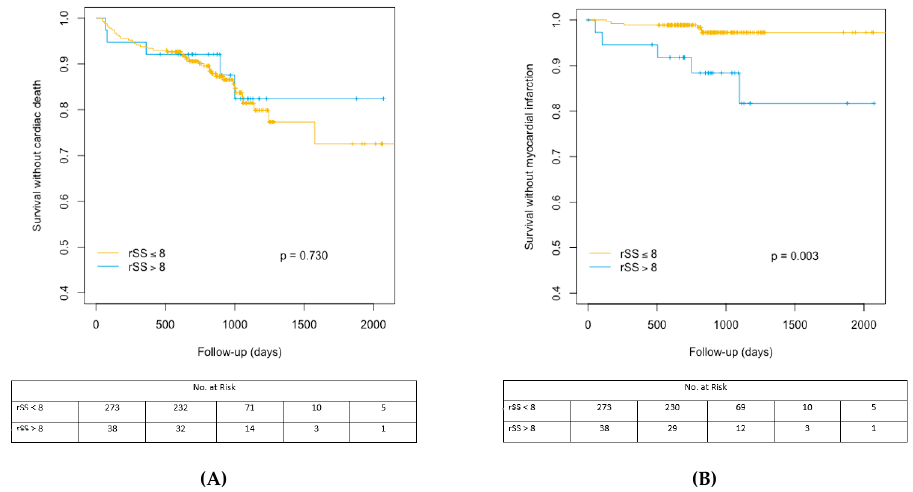
Figure 2. ( A ) Cumulative incidence analysis for the probability of cardiac survival according to